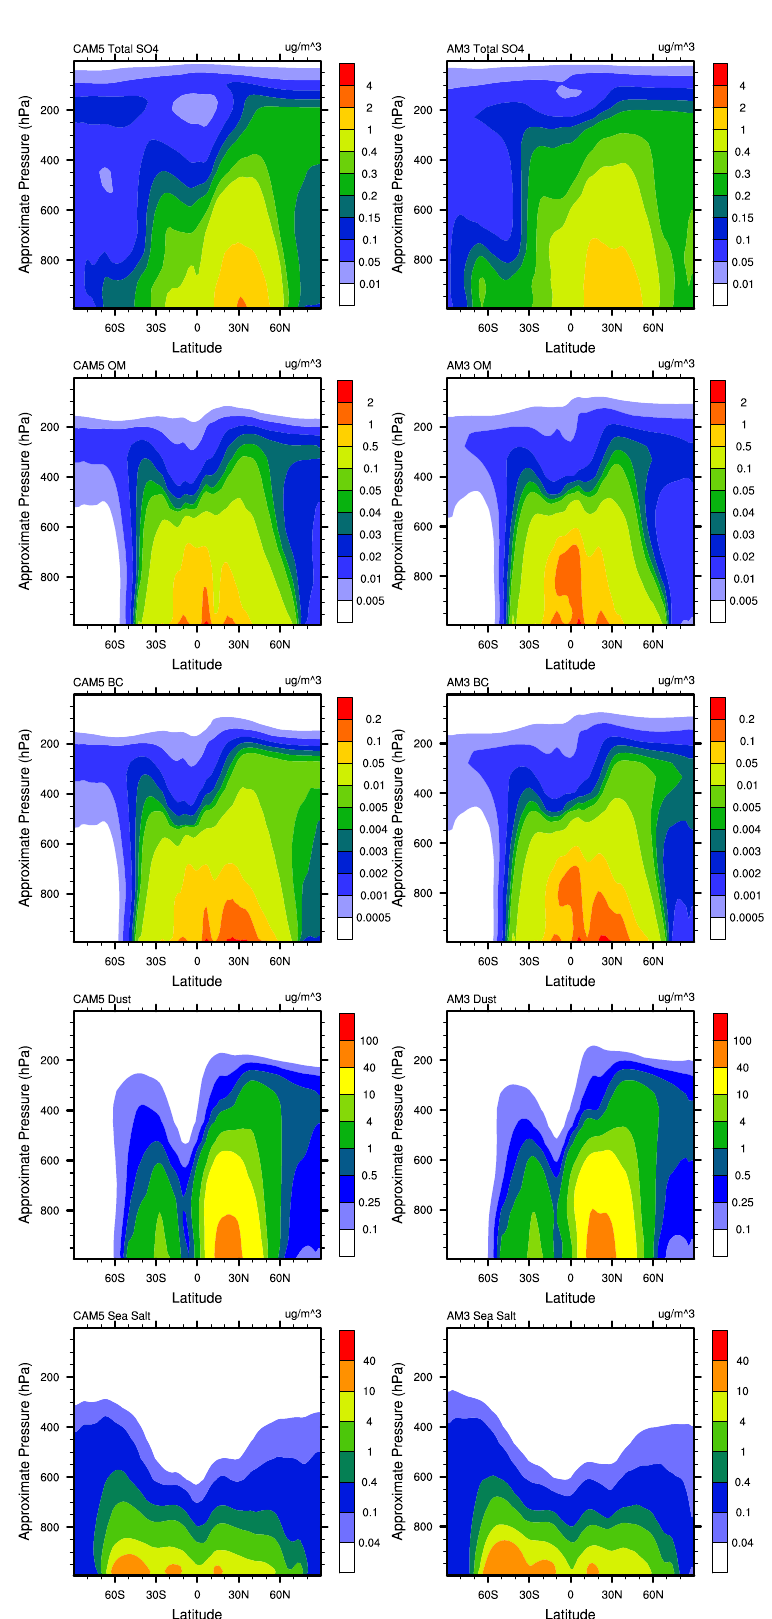
Fig. 7. Annual zonal mean concentrations of sulfate, OM, BC, dust and sea salt (from top to bottom) from case C1 (left) and A1 (right). www.atmos-chem-phys.net/12/9629/2012/ Atmos. Chem. Phys., 12, 9629–9652,